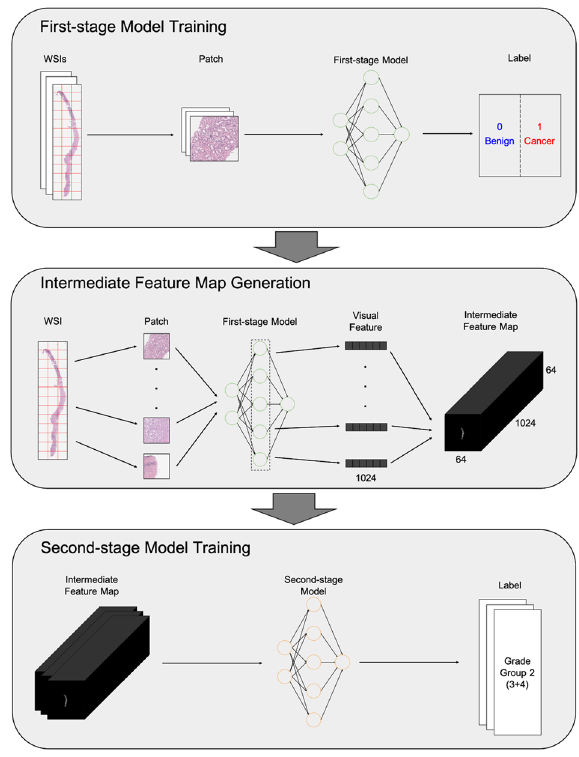
Fig. 4 Model training process of YAAGGS. The model classi fi es the input WSIs into Gleason grade groups in two stages. In the fi rst stage of feature extraction, patch images of size 360 × 360 pixels covering the entire slide area are extracted from the input WSI at 10× magni fi cation and fed into the fi rst stage CNN model to extract 1024-dimensional feature vectors. The extracted feature vectors were aligned according to the locations of corresponding patch images to be assembled into a 1024-channel two-dimensional feature map. The second stage CNN model accepts the feature maps as input and classi fi es them into one of six categories: benign, grade group 1, grade group 2, grade group 3, grade group 4, and grade group